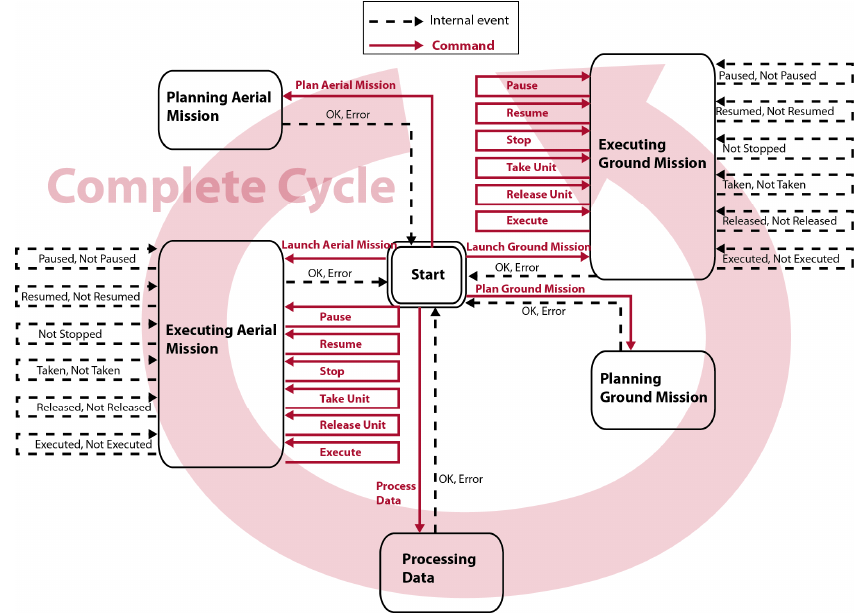
Figure 5. State diagram for the dispatcher.